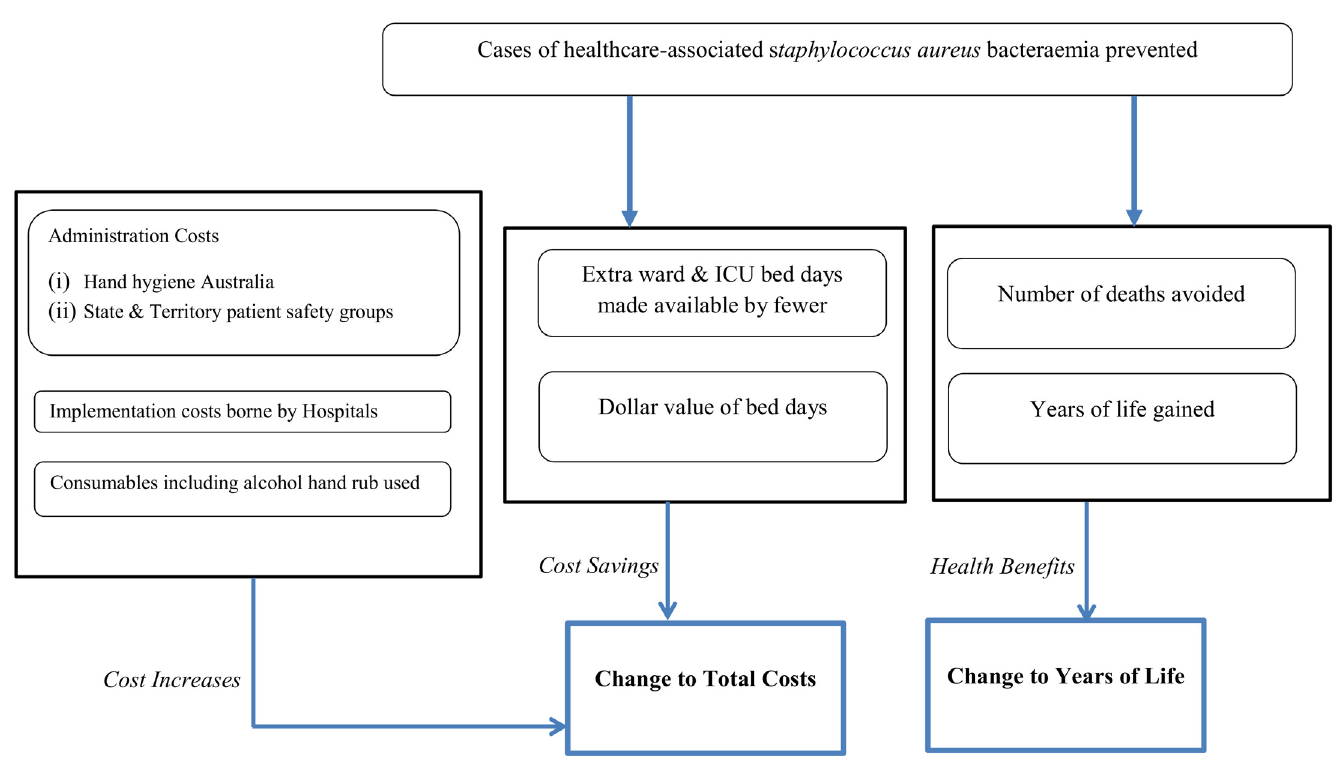
Fig 1. How information is structured to predict incremental cost-effectiveness